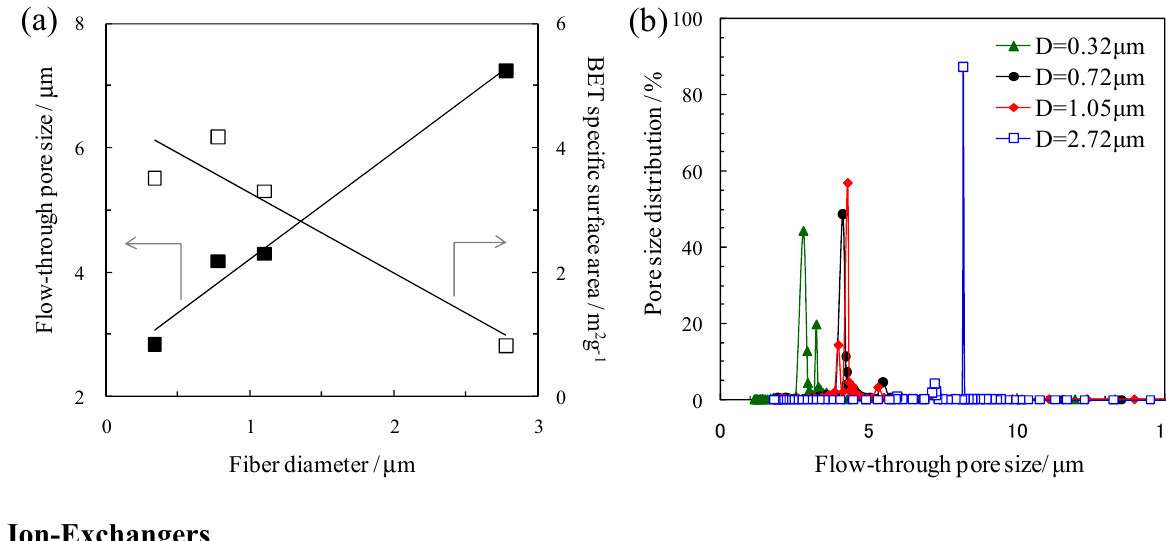
Figure 5. ( a ) Effect of fiber diameter on flow-through pore size between fibers and specific surface area of electrospun silica nanofibrous membranes; ( b ) Pore size distribution of electrospun silica nanofibrous membranes with various fiber diameters (D). The average pore size and pore size distribution were characterized by the bubble-point method (ASTM F316-86, JIS K3832) (Adapted from